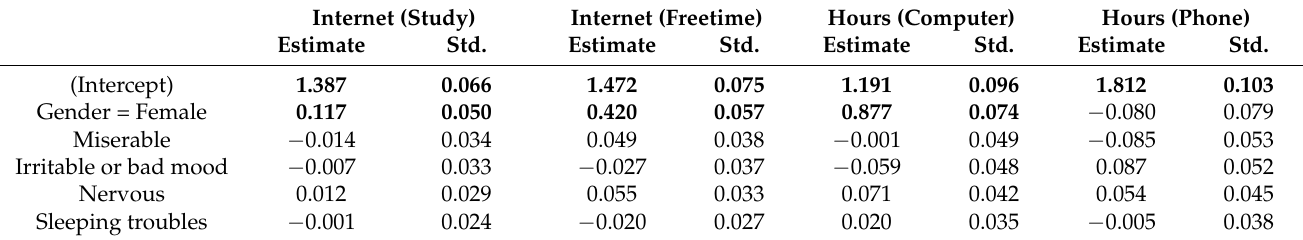
Table 3. Regression coefficients for psychological symptoms models.